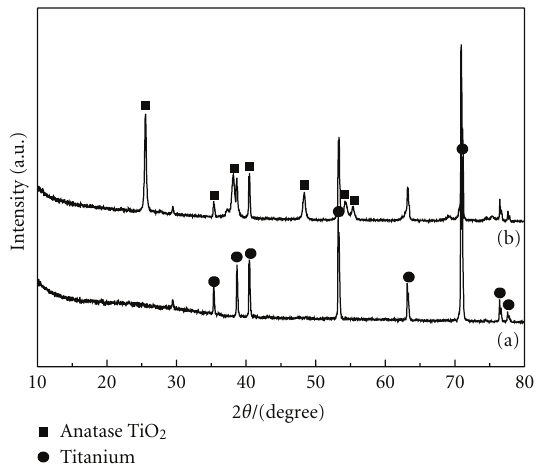
Figure 2: XRD patterns of as-prepared TiO 2 nanotube arrays before and after annealing in N 2 stream at 500 ◦ C for